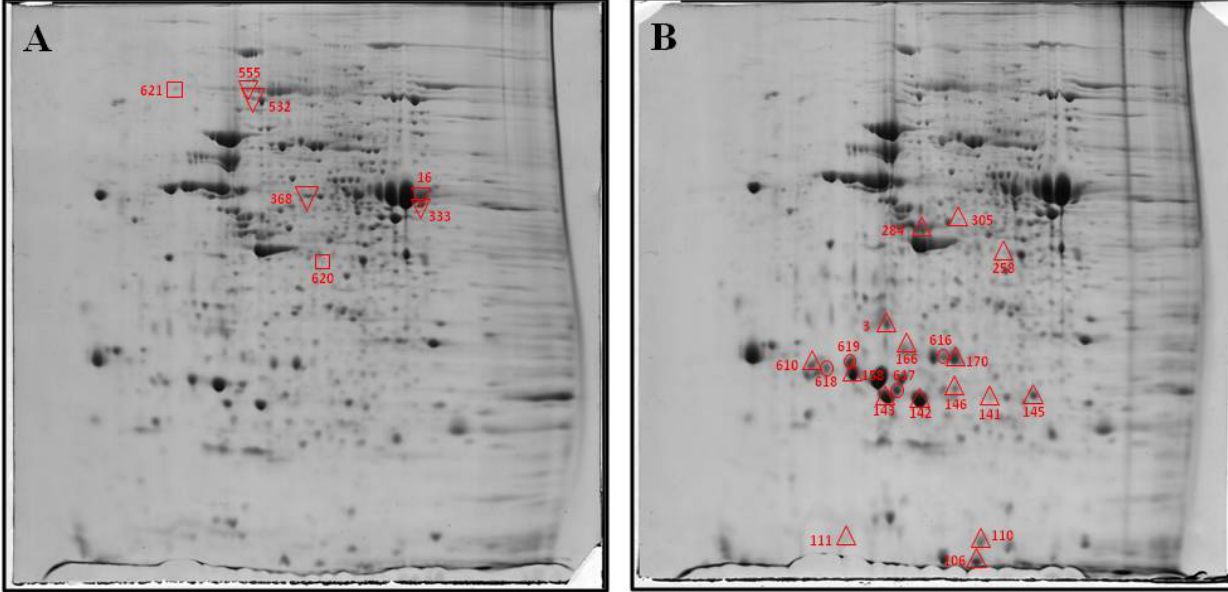
and db / db ( B ) mouse. Proteins were separated by isoelectric focusing (IEF) in the first dimension, pH 3–10 enriched in range from 4–8, then by size in the second dimension. Spots found with differential expression are marked in the gels. A : □ , proteins presents only in control mice and,  , diminished proteins in db/db mice; B :  , increased proteins in db / db mice and, O spots found only in db / db